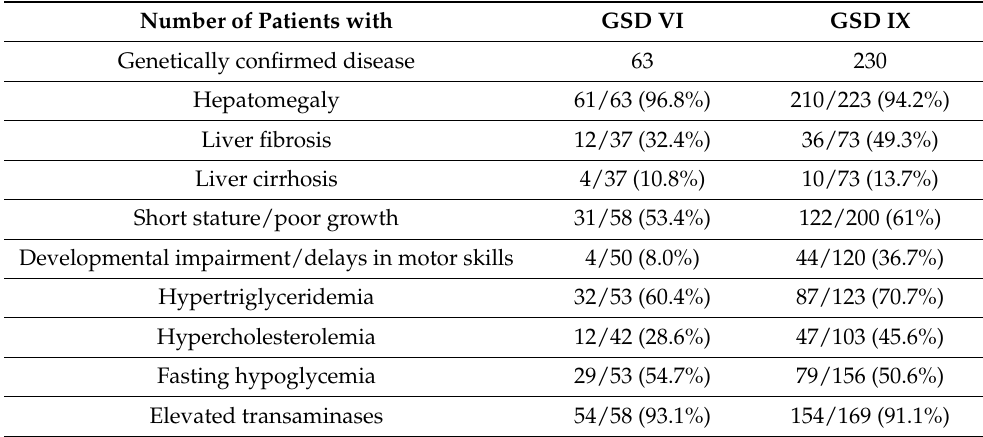
Table 3. Comparison of the frequency of clinical and laboratory findings in patients with GSD VI and GSD IX. Number of Patients with GSD VI GSD IX Genetically confirmed disease 63 230 Hepatomegaly 61/63 (96.8%) 210/223 (94.2%) Liver fibrosis 12/37 (32.4%) 36/73 (49.3%) Liver cirrhosis 4/37 (10.8%) 10/73 (13.7%) Short stature/poor growth 31/58 (53.4%) 122/200 (61%) Developmental impairment/delays in motor skills 4/50 (8.0%) 44/120 (36.7%) Hypertriglyceridemia 32/53 (60.4%) 87/123 (70.7%) Hypercholesterolemia 12/42 (28.6%) 47/103 (45.6%) Fasting hypoglycemia 29/53 (54.7%) 79/156 (50.6%) Elevated transaminases 54/58 (93.1%) 154/169